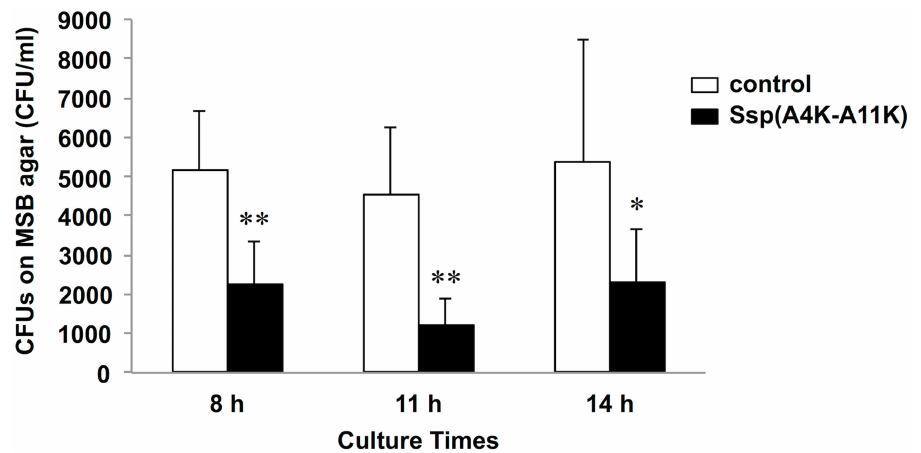
Fig 5. Inhibition using Ssp(A4K-A11K) for S . mutans biofilm formation on s-HA. The amounts of biofilms were measured by counting of colony-forming units (CFUs). Data are expressedas the means ± SDs of three independent experiments with technicalreplicates (vs. control: non-treateds-HA; * P < 0.05, ** P < 0.01).